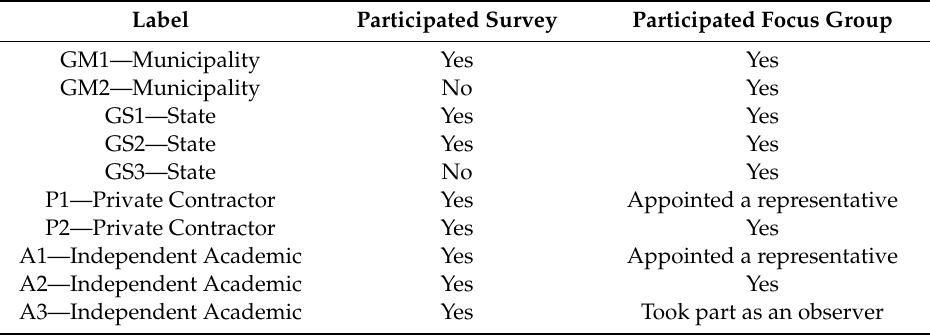
Table A1. Study Participants.